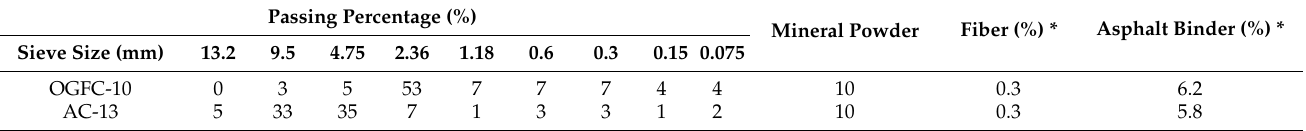
Table 2. Design parameters of OGFC-10 and